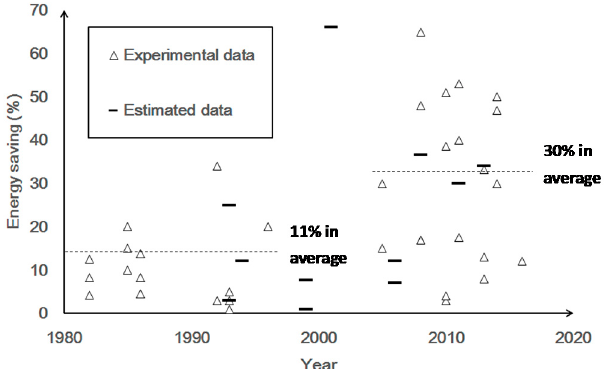
Figure 3. Energy savings (%) achieved by smart air conditioning researches, enabled by sensor and occupancy detection technology from 1982 to 2016.